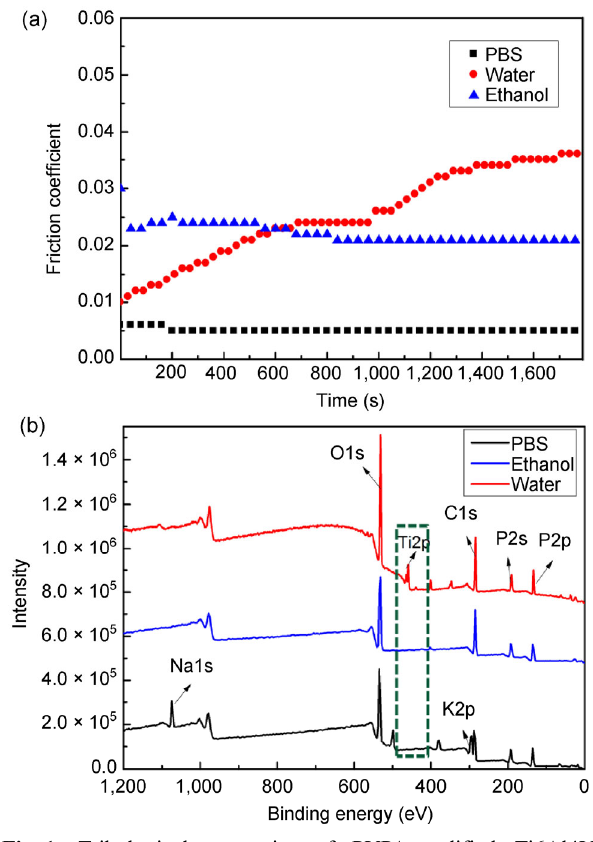
Fig. 1 Tribological properties of PVPA-modified Ti6Al4V lubricated by PBS, water, and ethanol: (a) variations in the friction coefficient of PVPA-modified Ti6Al4V sliding against PTFE balls, and (b) XPS survey scans of the wear track on PVPA-modified Ti6Al4V after sliding for 0.5